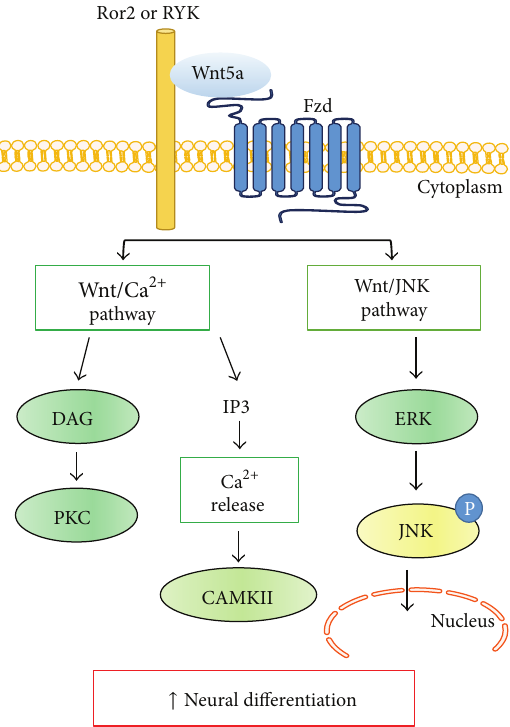
Figure 4: Noncanonical Wnt5a signalling: a simplified view. Wnt5a ligand binds to one of the seven transmembrane receptors of the Fzd family and results in Wnt/Ca 2+ pathway or Wnt/JNK pathway activities. Previously, Wnt/Ca 2+ pathway was already studied for other groups [27, 28]. Here, we demonstrate that Wnt5a upregulates ERK and phosphor-JNK signalling and activates the neural differ- entiation of